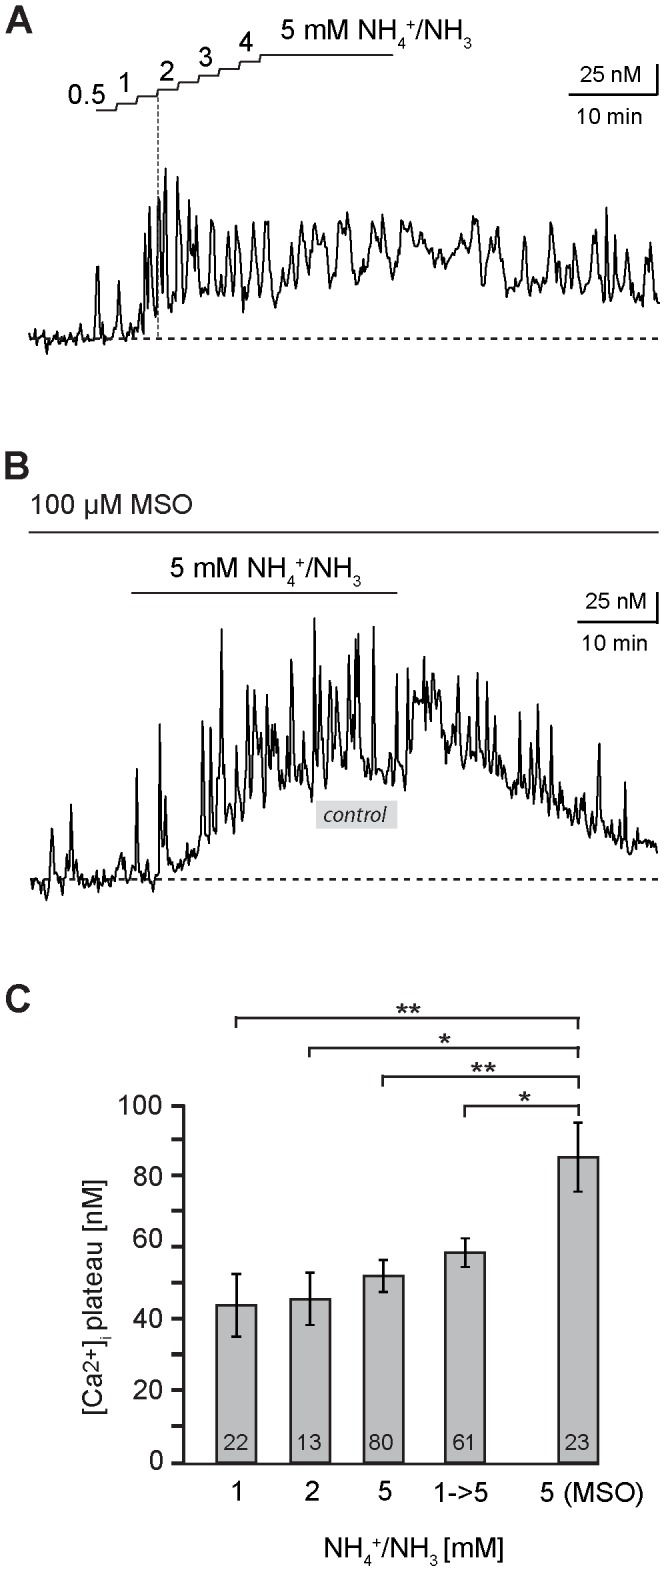
Dependence of astrocyte calcium changes on NH4
+/NH3-concentrations.
(A) Calcium changes in an hippocampal astrocyte evoked by stepwise increases in the NH4
+/NH3 concentration by 0.5 mM for 2 minutes, starting from nominally 0 mM up to a final concentration of 5 mM which was then maintained for another 15 minutes. (B) Influence of methioninesulfoximine (MSO, 100 µM) on NH4
+/NH3-induced calcium changes in a hippocampal astrocyte. The grey bar indicates the average amplitude of the sustained calcium increase evoked under control conditions in the absence of MSO (∼50 nM). (C) Histogram showing the mean peak amplitude ± S. E. M. of sustained calcium changes in response to 1, 2 and 5 mM NH4
+/NH3, after stepwise increases from 0 to 5 mM NH4
+/NH3 and in the presence of MSO and 5 mM NH4
+/NH3. The number of cells is given within the bars. Peak amplitudes of calcium changes did not differ between the different concentrations used. They were, however, significantly larger in the presence of MSO as compared to all other conditions (*: p<0.05; **: p<0.01).